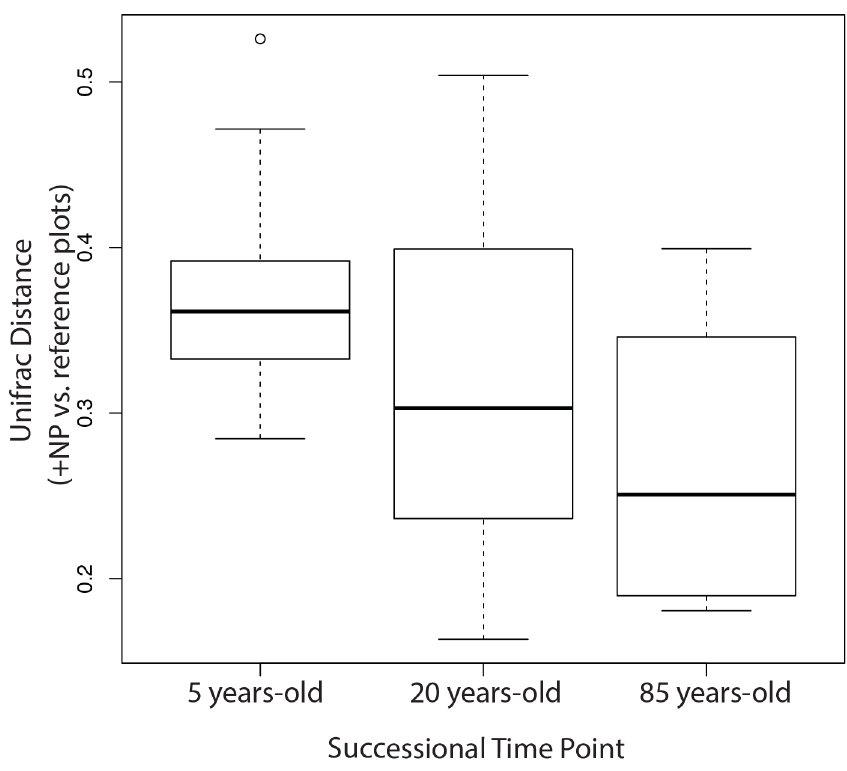
Figure 2. Relationship between + NP treatment-affected communities and reference communities. A box plot shows the average weighted UniFrac [43,44] distance between + NP-treated communities and reference communities with increasing successional time. A Mantel test demonstrates that + NP communities show decreasing dissimiliarty as compared to the reference communities over advancing stages of succession ( r M = 2 0.35 P=0.01).